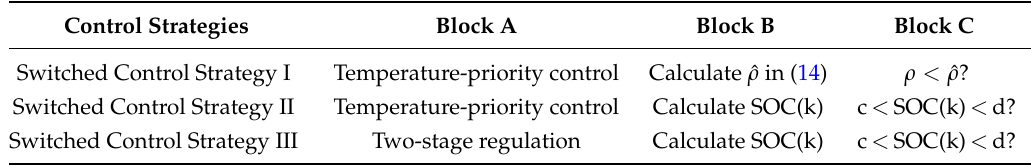
Figure 7. Flow chart of the switched control strategies. Table 3. Flow chart